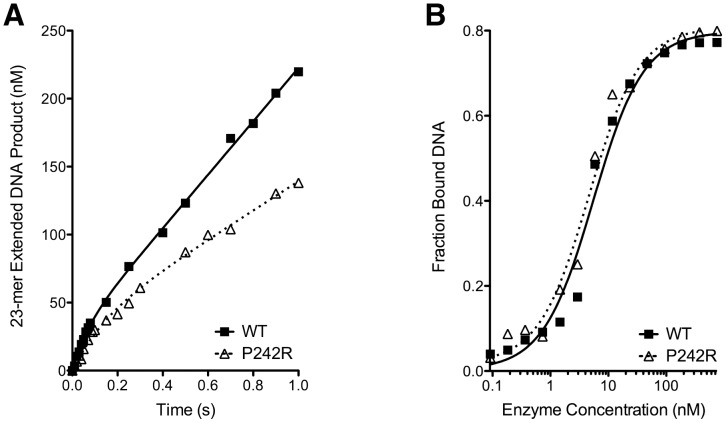
The P242R germline variant of Pol β is slow and binds DNA tightly.A. Representative results from a presteady-state burst assay. Results for the WT are shown as filled squares fit with a solid curve. Results for the P242R are shown as open triangles fit with a dashed curve. The assay was repeated four times for each protein. B. Representative results from a gel electrophoretic mobility shift assay. Results for the different proteins are shown as in A.